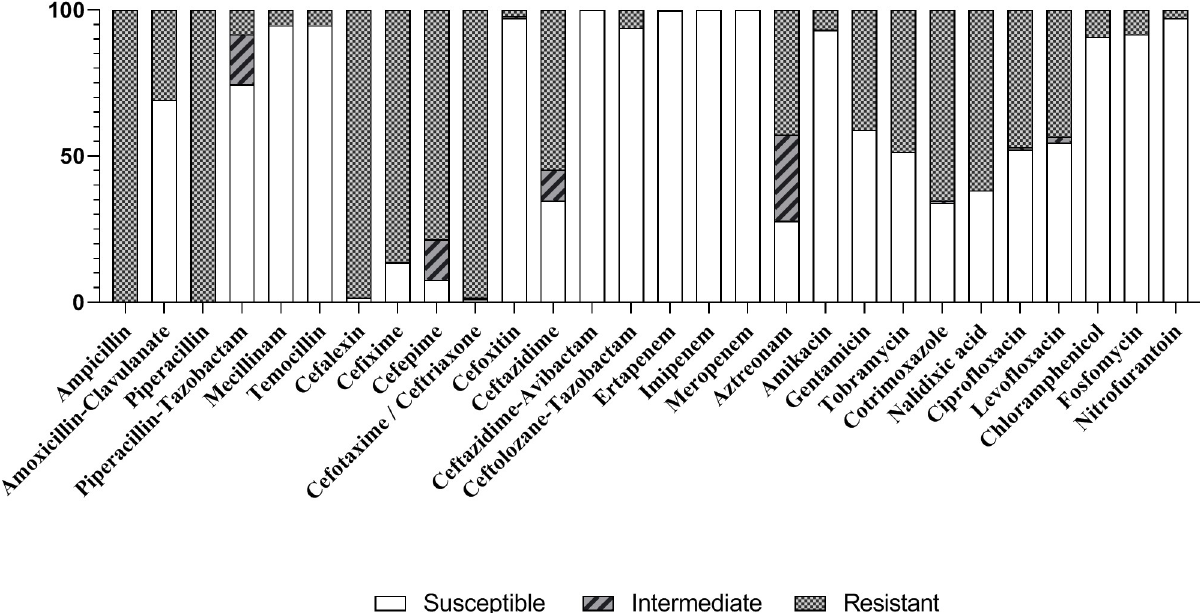
Fig 2. Susceptibility drug testing of the ESBL producing strains analyzed by the National Reference Center. Susceptible, resistant and intermediate results were analyzed following the latest EUCAST guidelines.